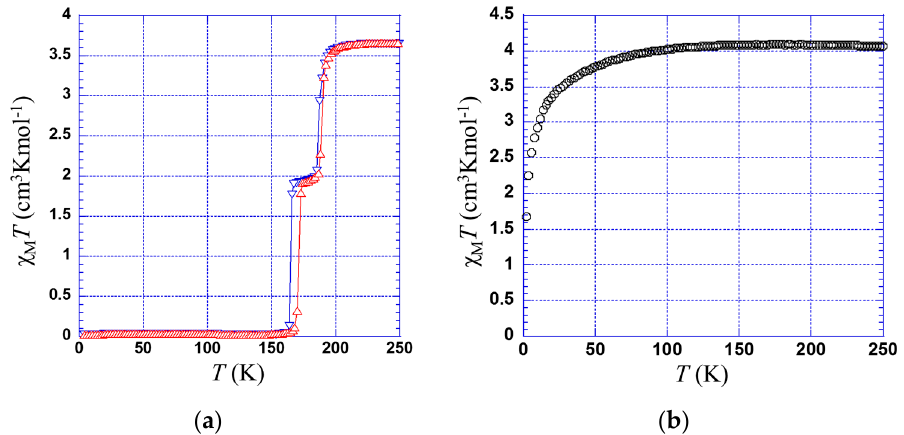
Figure 3. ( a ) Thermal dependence of χ M T for compound 1 . The sample was cooled from 300 to 2 K (blue) and then warmed from 2 to 300 K (red). ( b ) Thermal dependence of χ M T for compound 2 .